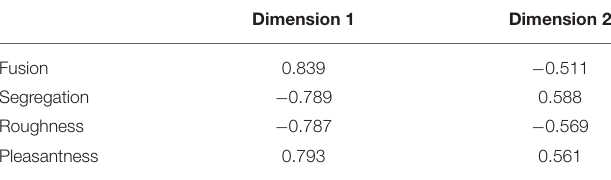
TABLE 3 | Component loads of timbre perception attributes in two